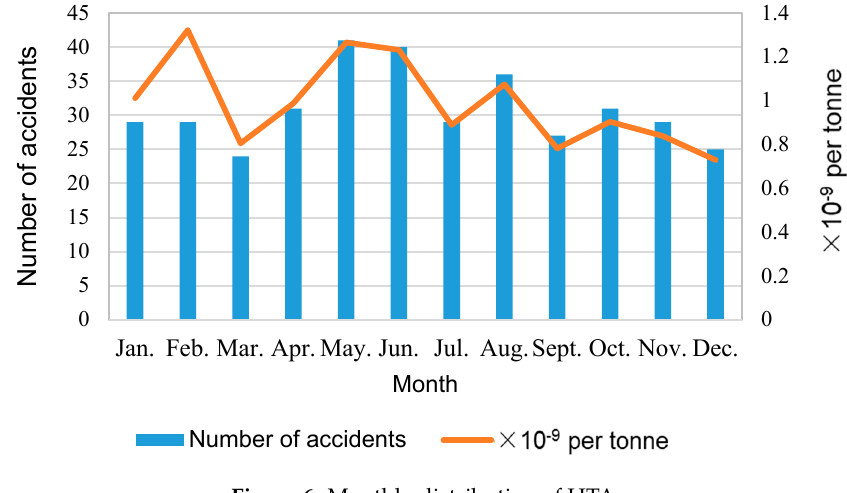
Figure 6. Monthly distribution of HTAs.